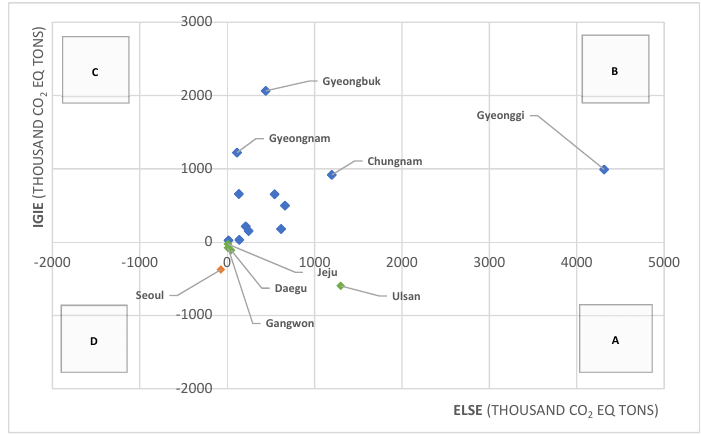
Figure 3. Results of classification of Korean LRGs.